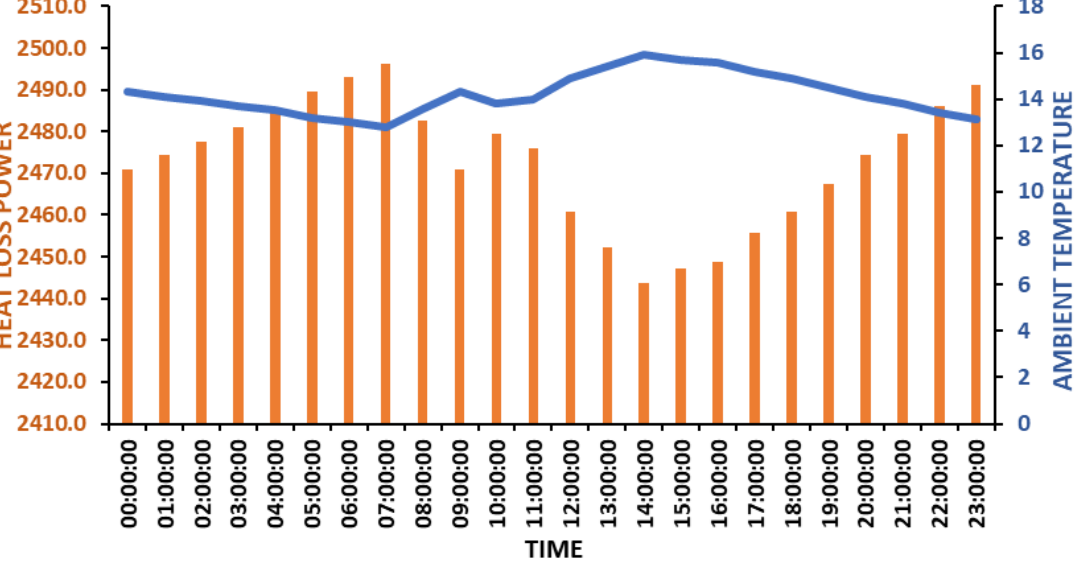
Figure 8. Heat loss power to maintain the tank at a temperature of 150 °C, depending on the ambient temperature.